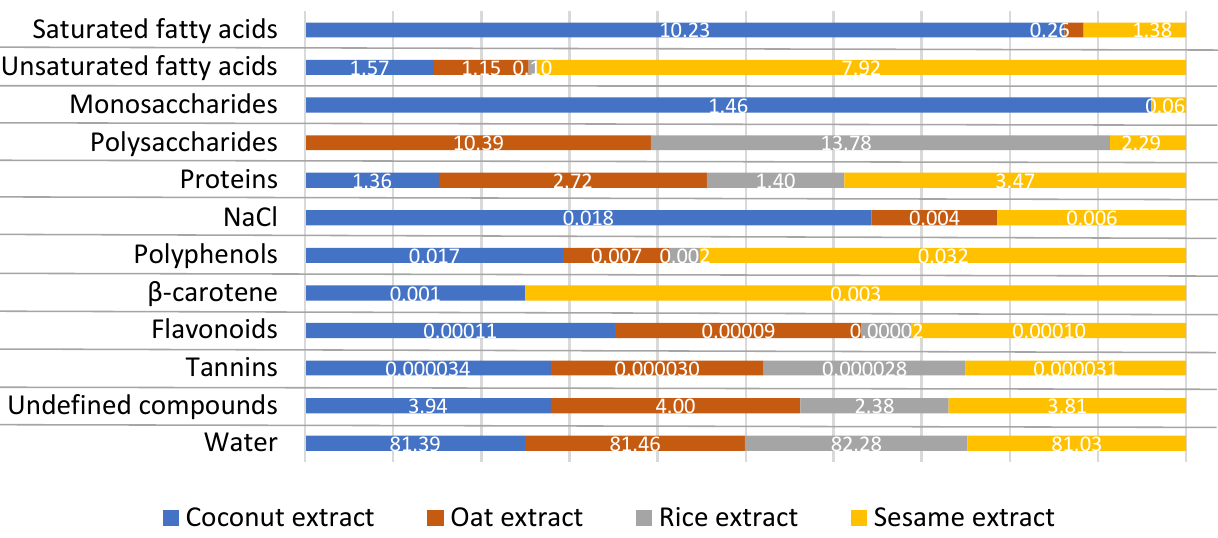
Figure 2. Profile of various organic and inorganic compounds (%) in plant extracts used in the study. Length of the bars presents the proportion between the concentration of the same component (%) within various extracts.